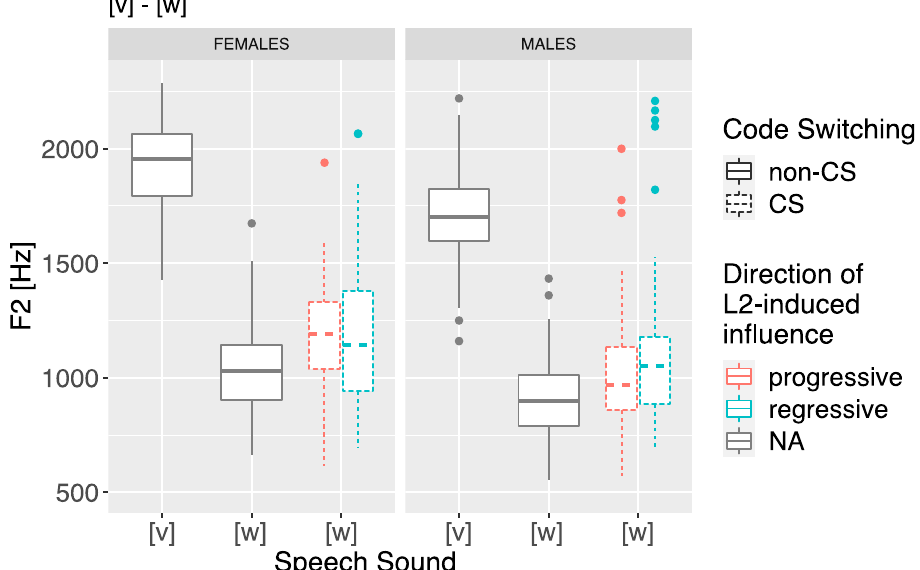
Figure 2. F2 of the intended [v] and [w] sounds in English words, spoken by BIL speakers in non-CS (solid) and in CS environments; productions in CS environments are divided into progressive (red) and regressive (blue) L2-induced influences. The left panel shows female data, the right panel male data.